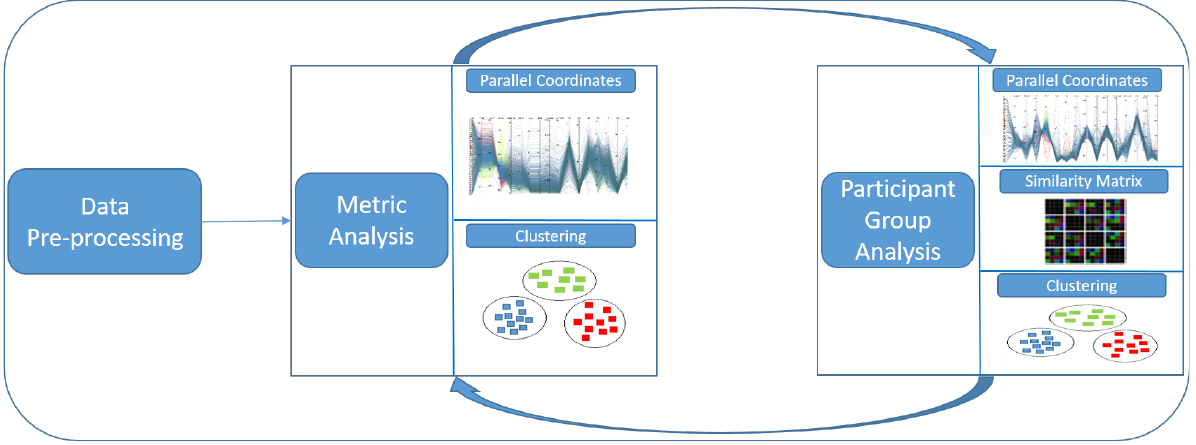
Figure 1. Work-flow overview: Preprocessed data are fed into parallel coordinates plot for visual clustering and providing group- ing information that can be used in the similarity matrix visualization. Gained insights serve to steer the analysis based on parallel coordinates and algorithmic